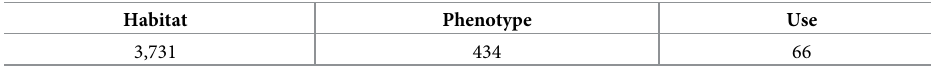
Table 1. Number of classes per branch in the OntoBiotope